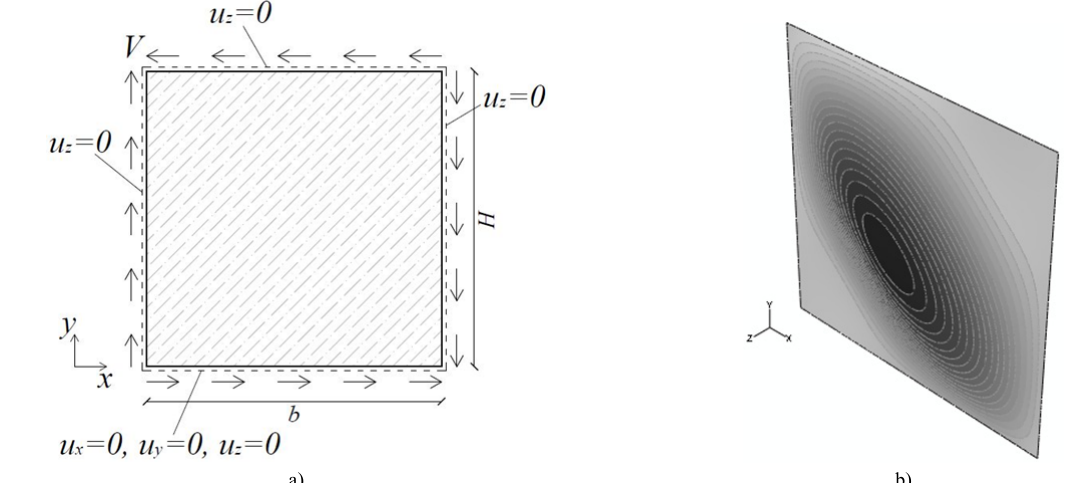
Fig. 1 Theoretical model for a simply supported, isotropic plate under in-plane shear. a) Reference system and b) fundamental deformed